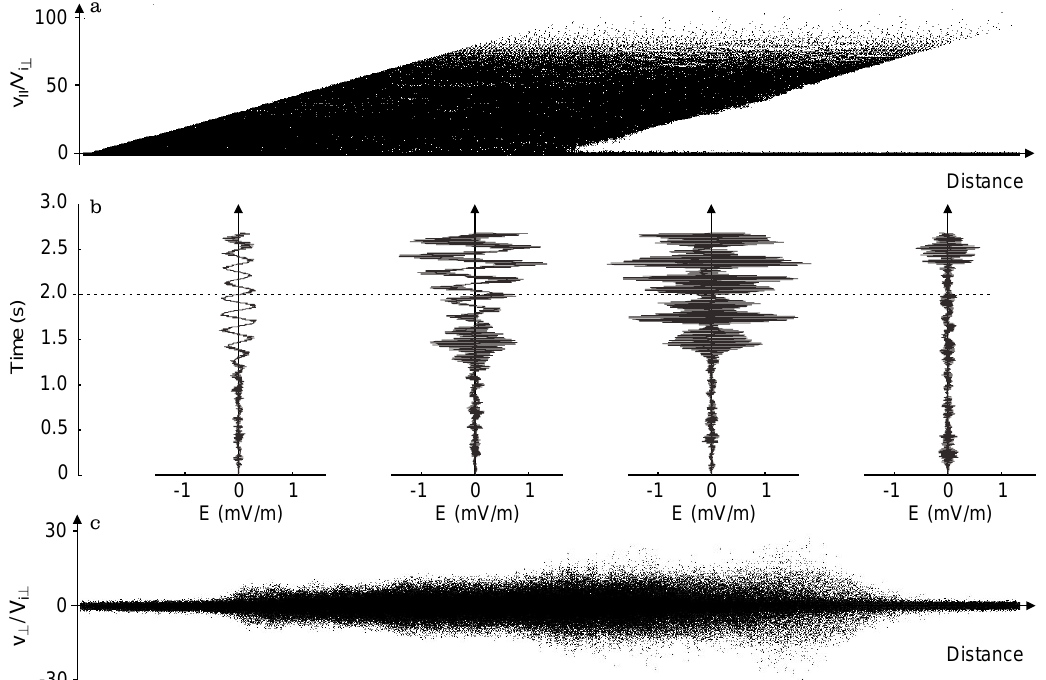
Fig. 8a–c. Inhomogenous beam simulation. a Shows simulation particles in v marked positions. c Shows simulation particles in v ? (cid:255) x plane. a and c are snapshots after 2